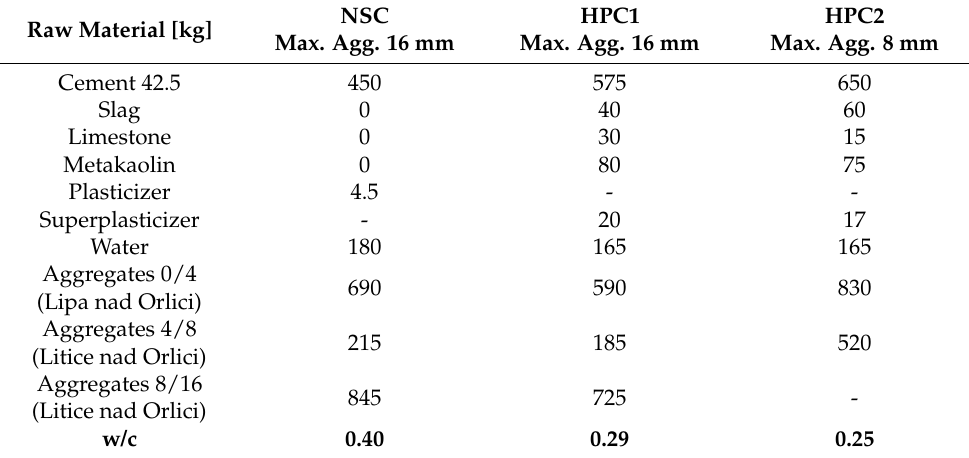
Table 1. Concrete mixture of normal strength concrete (NSC) and high-performance concrete